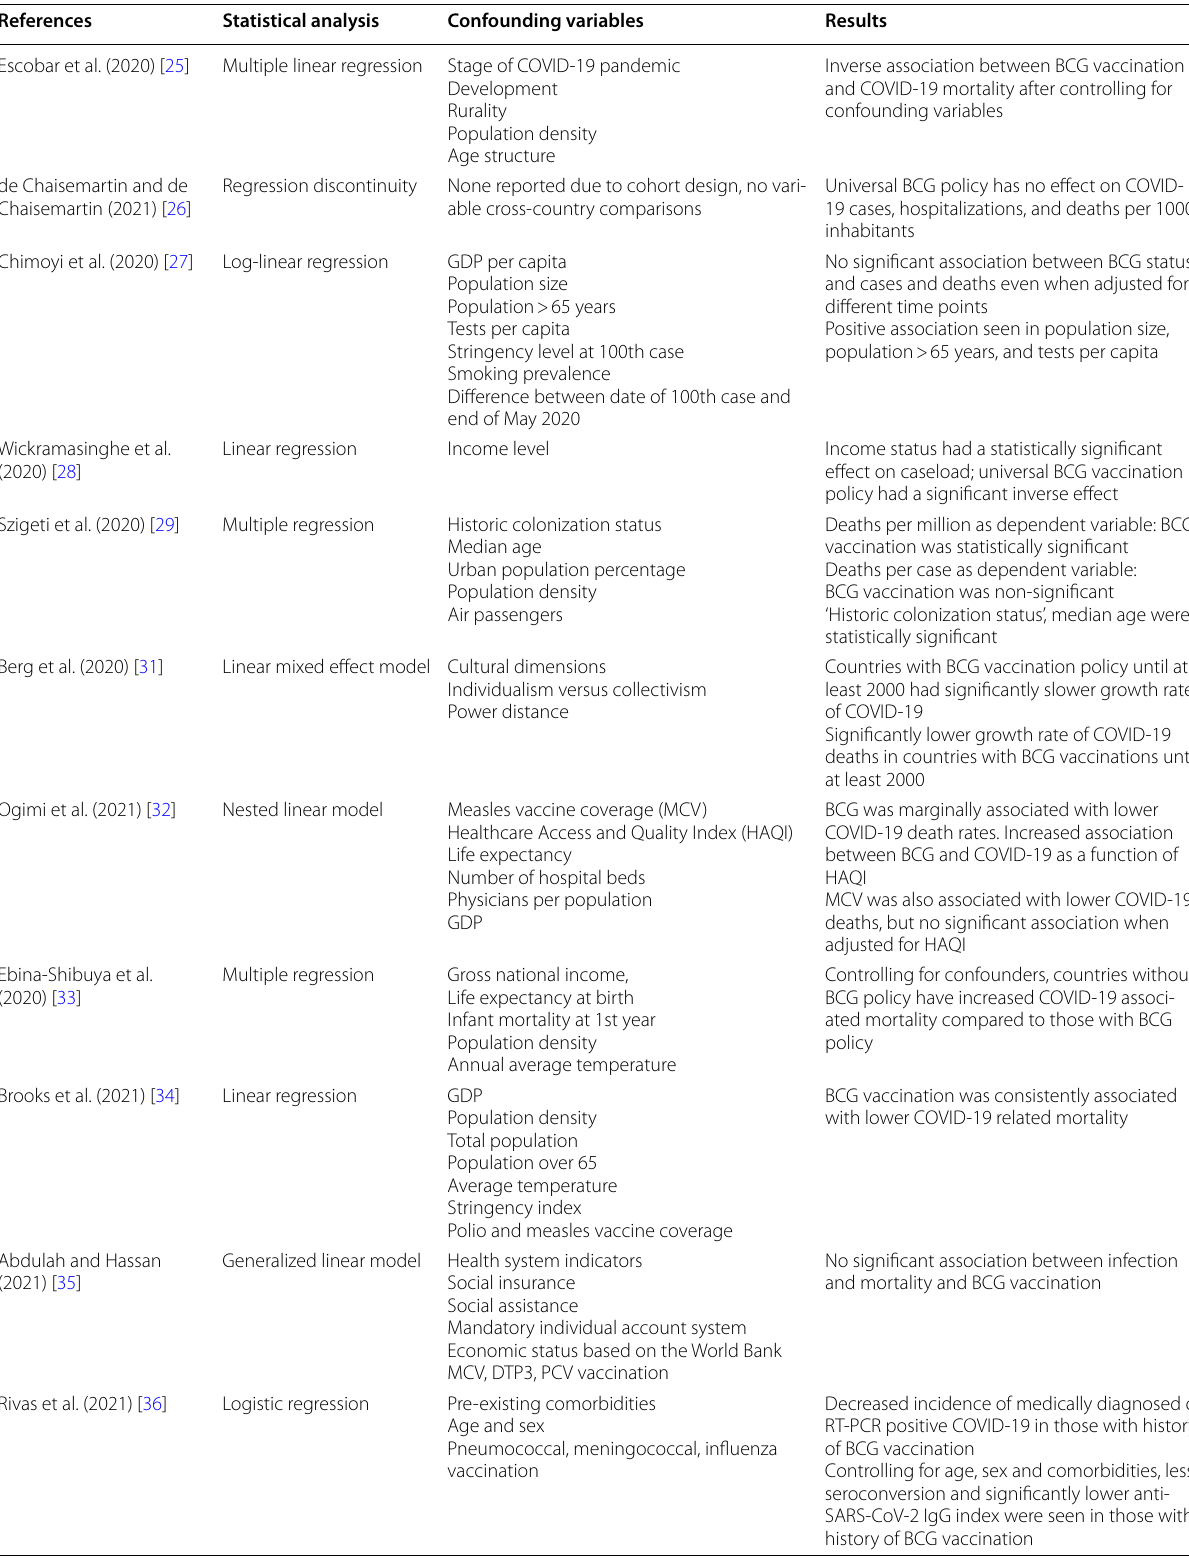
Table 4 Effects of BCG vaccination on morbidity and mortality based on association and confounding